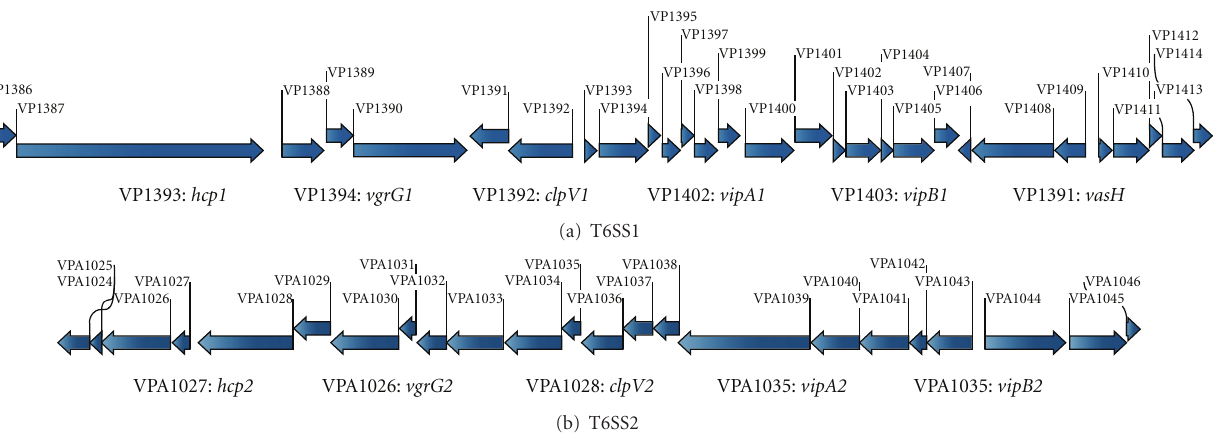
Figure 1: Organization of T6SS gene clusters in V. parahaemolyticus . The arrows indicated the present and gene order of the T6SS1 (a) and T6SS2 (b) loci on chromosomes I and II, respectively, which was based on the genome sequence of V. parahaemolyticus RIMD 2210633 [7].